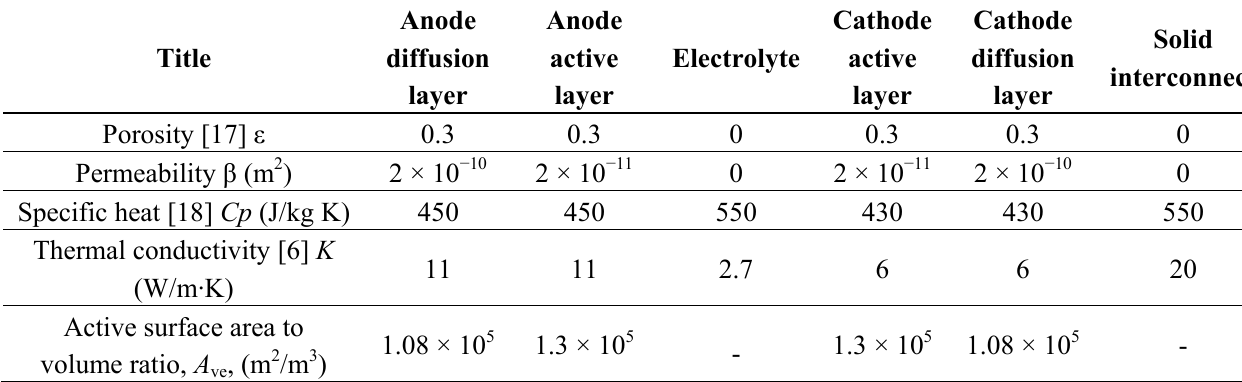
Table 4. Properties for different components of the